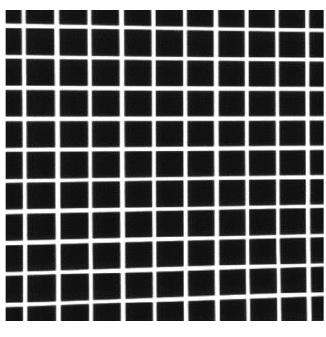
Figure 2. The binary grid pattern.